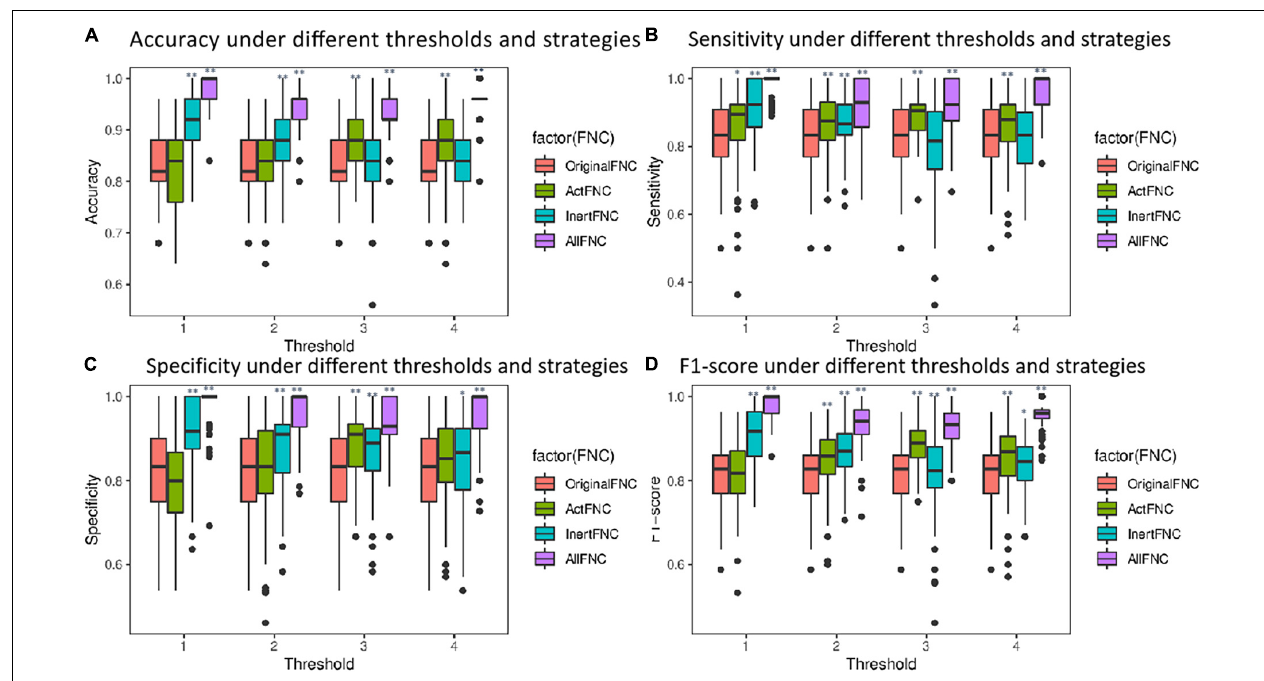
FIGURE 7 | Box plots comparing the performance of classification using different features. Red represents the OriginalFNC, green represents the ActFNC, blue represents the InertFNC, and purple represents the AllFNC. (A–D) The horizontal axis is the threshold µ ; vertical axis represents the accuracy, sensitivity, specificity, and F1-score. ∗ indicates p < 0.05, and ∗∗ indicates p <